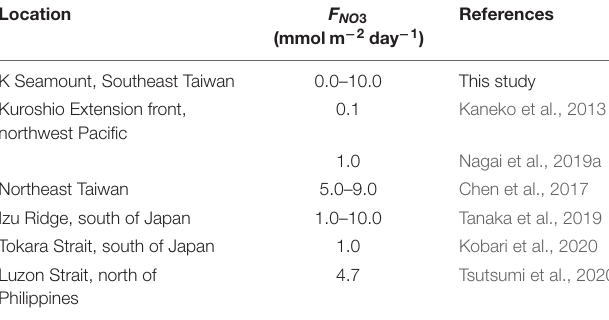
TABLE 1 | Estimates of nitrate flux ( F NO 3 ) along the Kuroshio where strong vertical mixing occurs.